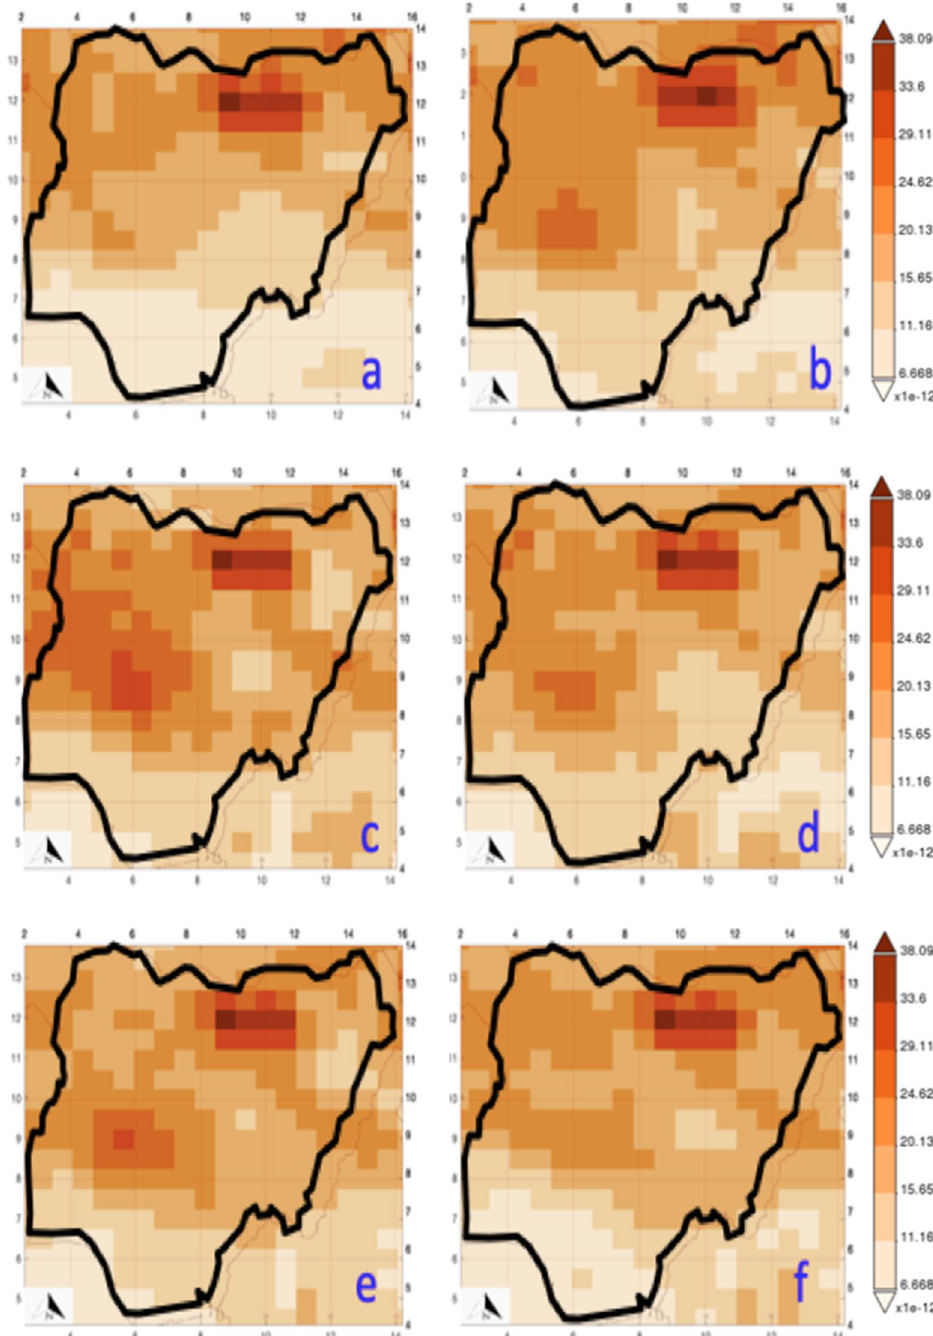
Figure 6. Dust dry deposition ( a ) 2010 ( b ) 2014 ( c ) 2015 ( d ) 2016 ( e ) 2017 ( f )